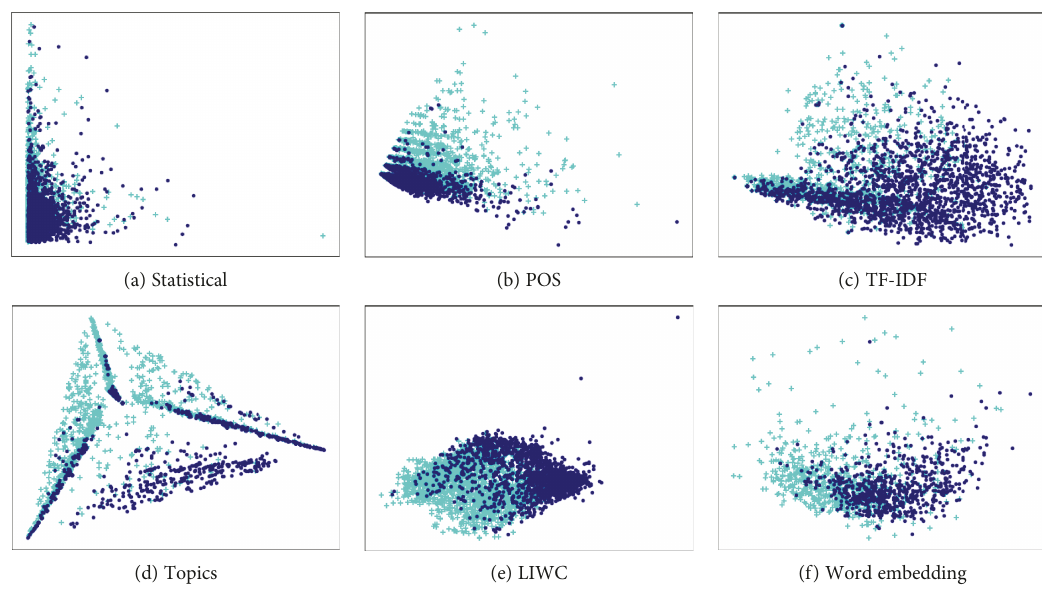
Figure 2: Visualisation of extracted features using